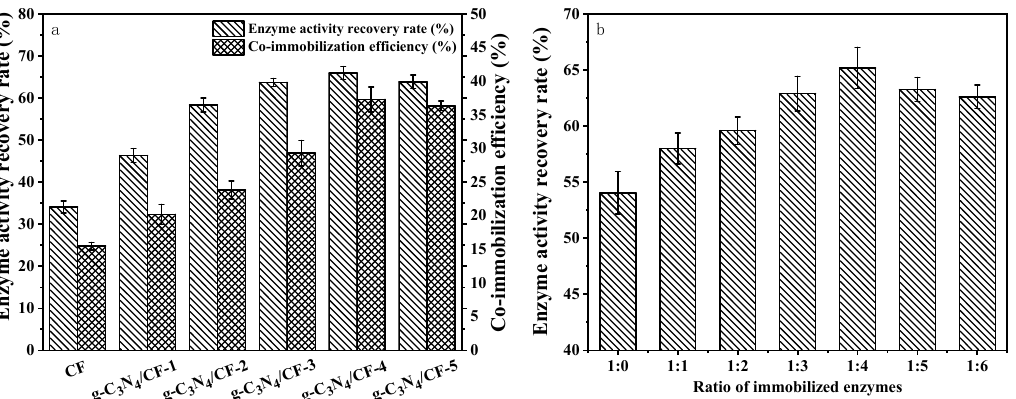
Figure 6. Effect of different carriers and enzyme activity ratios on co-immobilized enzyme activity. ( a ) Effect of different carriers on enzyme activity recovery and co-immobilization efficiency; ( b ) effects of double enzyme ratio on enzyme activity recovery of g-C 3 N 4 /CF co-immobilization enzyme.